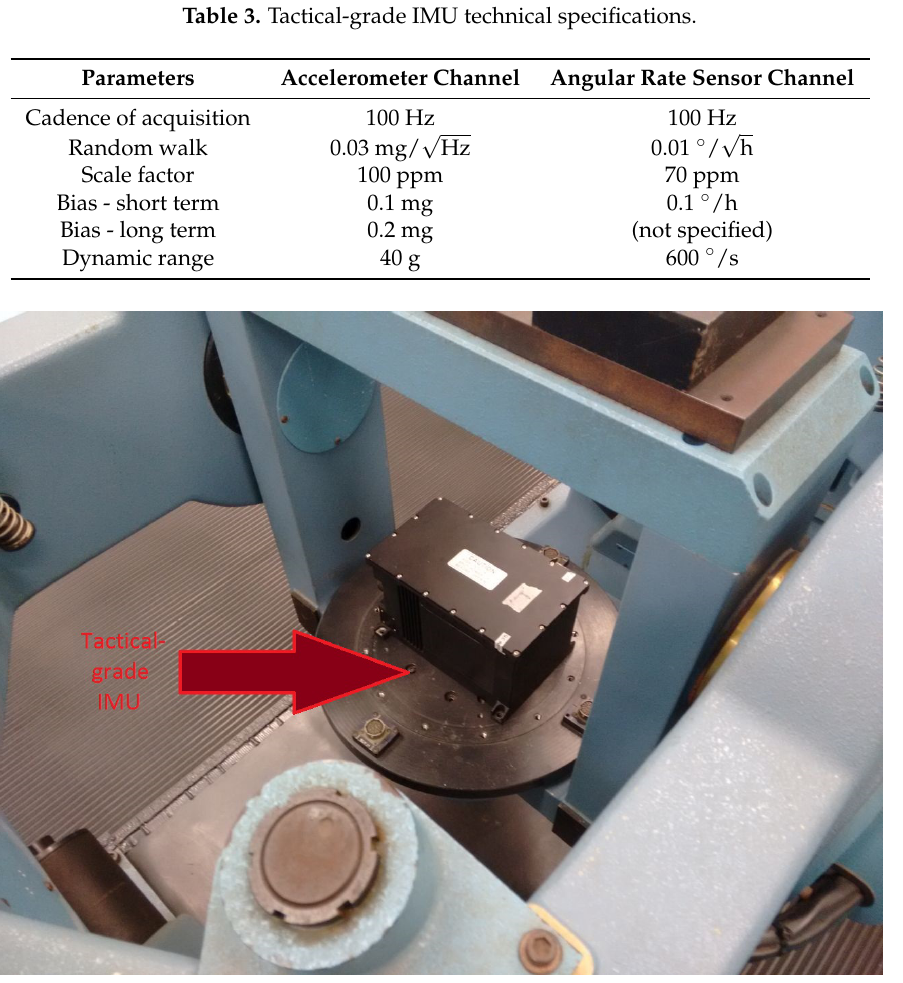
Figure 14. Tactical-grade IMU mounted on a three-axis rotary